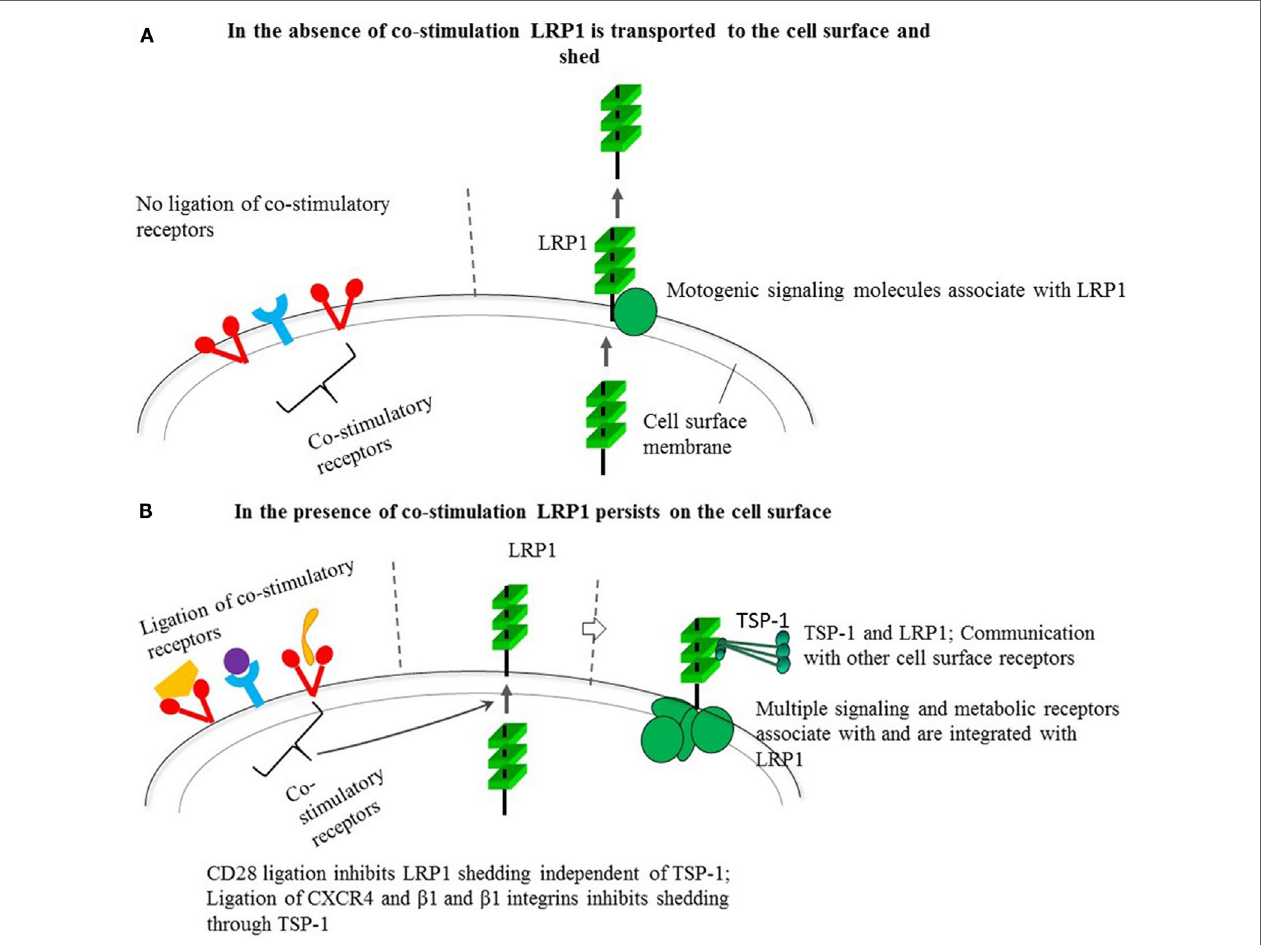
FiGURE 1 | Behavior of low-density lipoprotein receptor-related protein 1 (LRP1) in the absence (A) and presence (B) of co-stimulation through different receptors and its possible impact on cell signaling through the multiple molecular interactions and connections of LRP1 and its ligand thrombospondin-1 (TSP-1). The constitutive shedding-dependent low cell surface LRP1 as shown in a favors motility, whereas the upregulated level induced by co-receptor ligation by B7, integrin ligands, and CXCL12 also may trigger activating signals through LRP1-dependent expression of signaling and metabolic receptors as well as LRP1-associated TSP- 1. TSP-1 binds to cell surface receptors, components of the extracellular matrix, other matricellular proteins, growth factors, cytokines, and proteases (25). Besides its interactions with signaling molecules, as mentioned in the text, LRP1 can interact with multiple different exogenous ligands including α -2-macroglobulin, tissue plasminogen activator, plasminogen activator inhibitor, and apolipoprotein E. Apolipoprotein E is involved in fat metabolism and is produced by macrophages pointing to a possible influence on antigen presentation. It is conceivable that LRP1 and associated TSP-1 in collaboration can communicate with other cell surface receptors besides connecting to or integrating vital pathways for cell signaling or cell